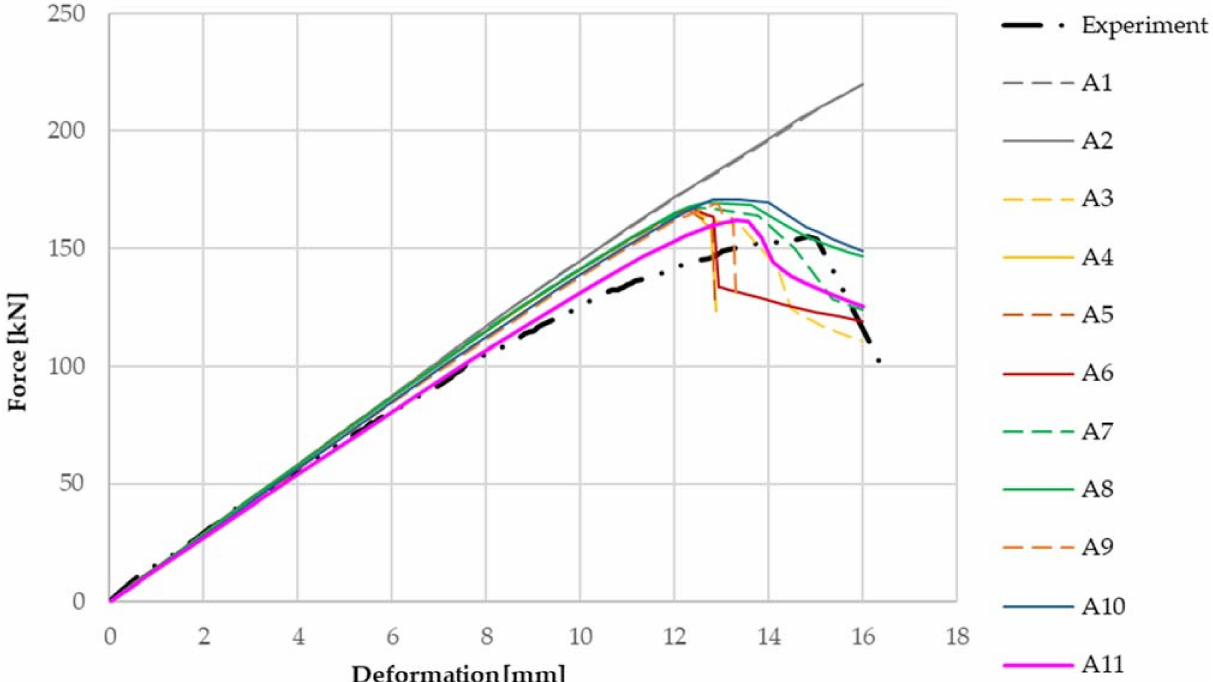
Figure 11. Results from numerical models and experiments using various parameters, with cleat.